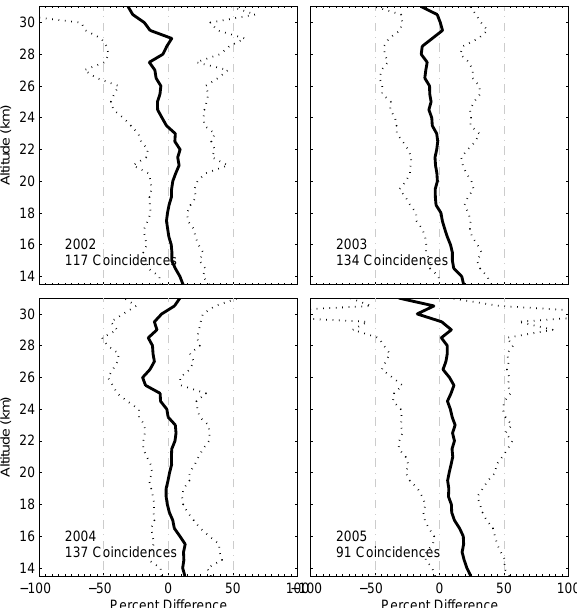
Fig. 5. Comparison of, for OSIRIS and SAGE III aerosol extinction coefficient at four altitude levels: 16.5km (blue), 19.5km (purple), 22.5km (maroon) and 25.5km (red). Each panel represent one of the four years of overlapping measurements: 2002 in top left, 2003 in top right, 2004 in bottom left and 2005 in bottom right. The mean and standard deviation given in the plots are calculated based on the ratio given in Eq.